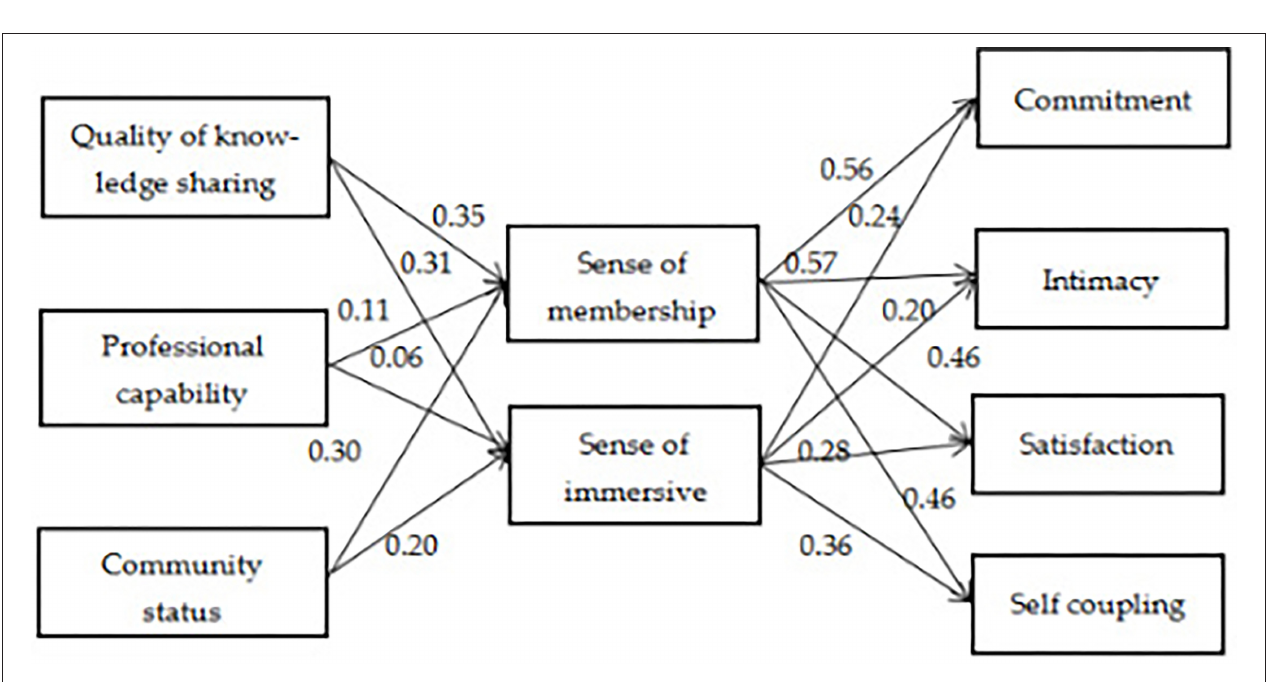
FIGURE 2 | Structural